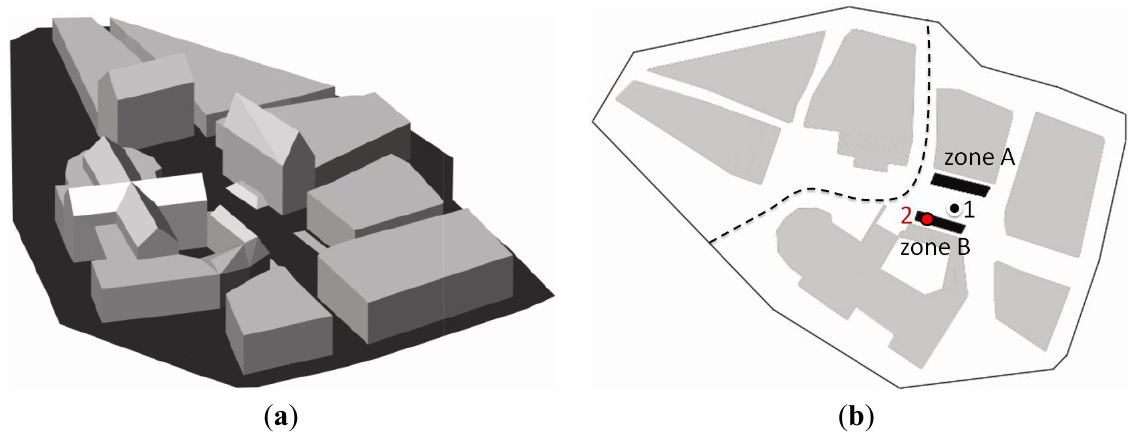
Figure 3. Geometric 3D model of Grote Markt including surrounding buildings ( a ) and the ground plan of Grote Markt with an indication of the outdoor restaurant zones A and B, and of the two listening positions: 1. in the middle of the square; 2. at the table in the restaurant. The dashed line indicates the trajectory of the buses ( b